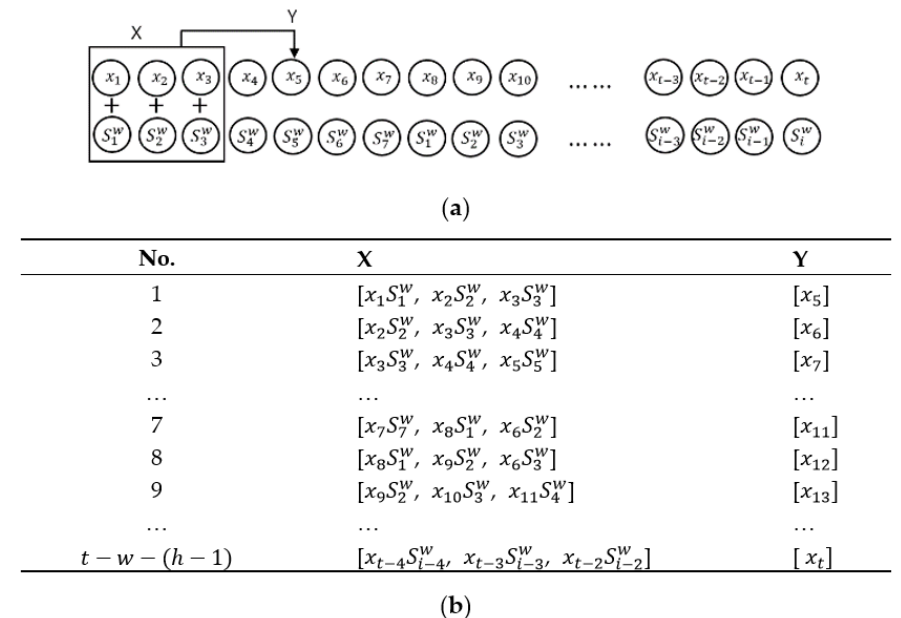
Figure 8. Seasonal long short-term memory (SLSTM) input data creation. ( a ) Data sampling with seasonality extension ( 𝑤 = 3 , ℎ = 2 𝑆 𝑖 = 𝑆 𝑖𝑤 ). ( b ) Representation of feature vector X and label Y.